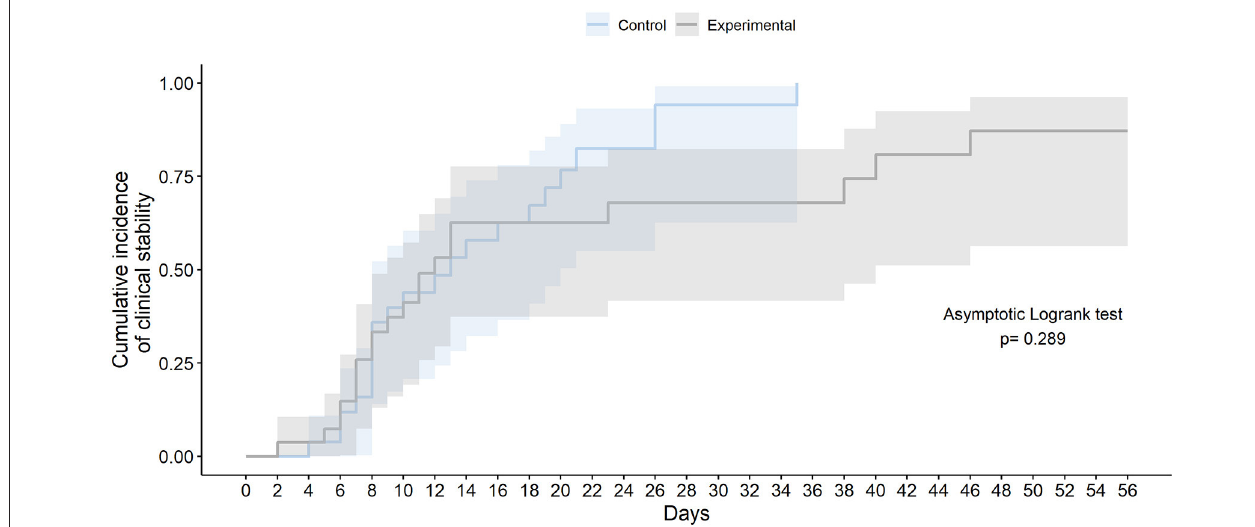
FIGURE 2 | Time to clinical stability in the intention-to-treat population.